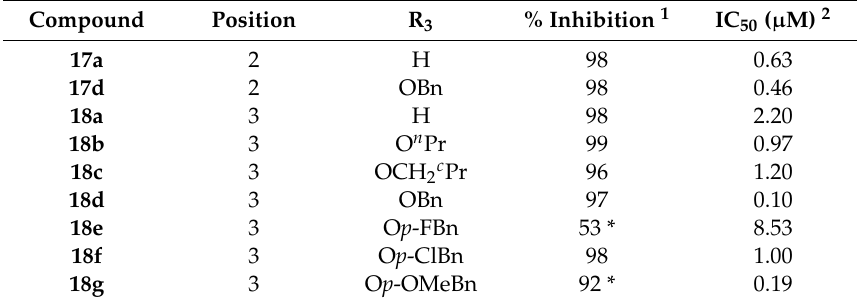
Table 2. SAR of tetrahydroisoquinoline linked aminopyridines 17 and 18